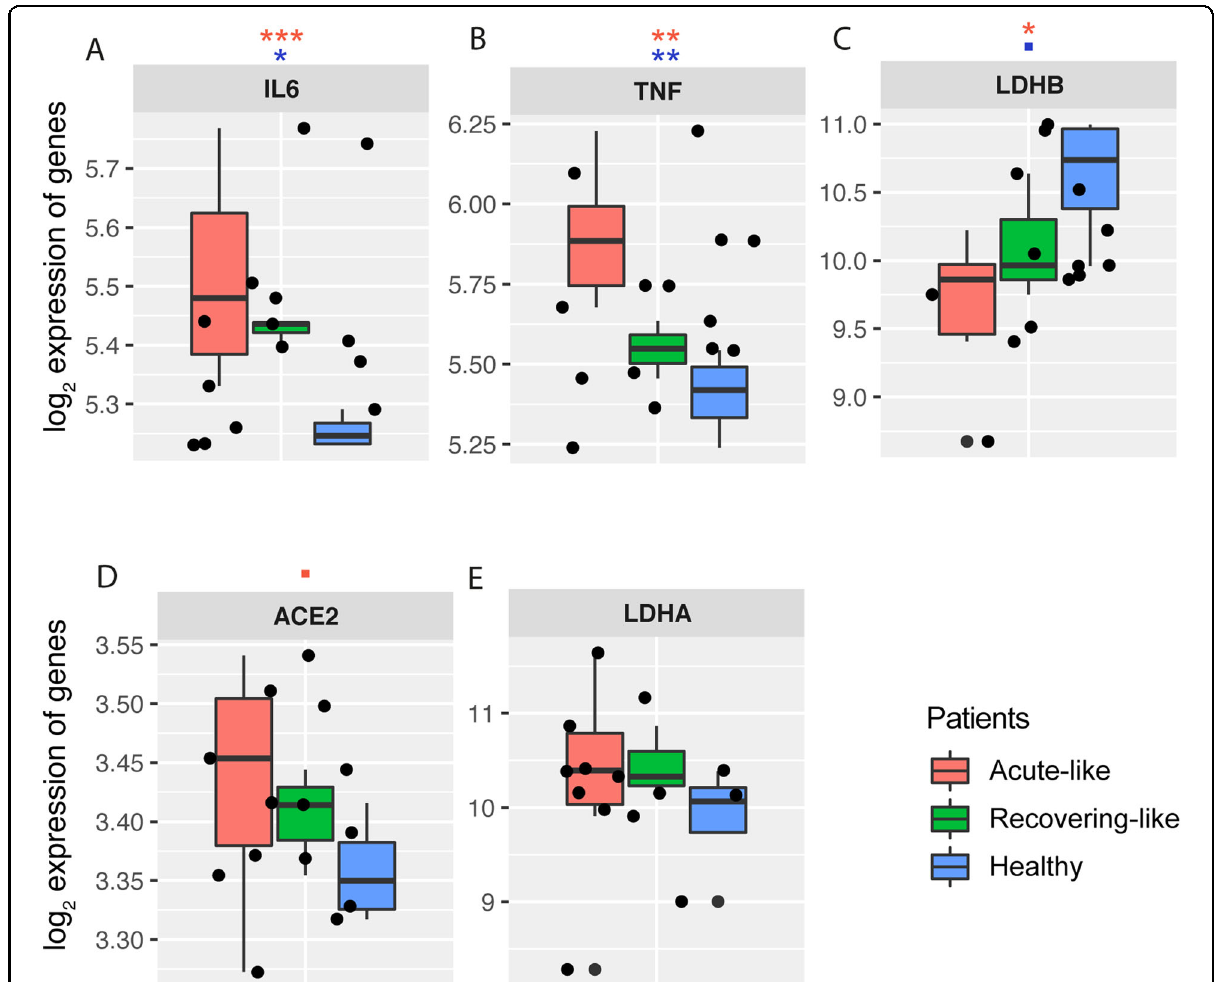
Fig. 2 Signi fi cantly represented key genes at different progression stages of coronavirus infection. A – E Expression levels of genes: IL6 ( A ), TNF ( B ), LDHB ( C ), ACE2 ( D ), and LDHA ( E ) in acute-like and recovering-like SARS patients and healthy individuals. Blue asterisk (*) represents Kruskal – Wallis nominal p value across all three groups and red asterisk (*) represent Welch two-sample t- test p value between patients and healthy individuals. * p < 0.05; ** p < 0.001; *** p < 0.0001 and ■ p < 0.08. Multiple testing was not done due to low sample